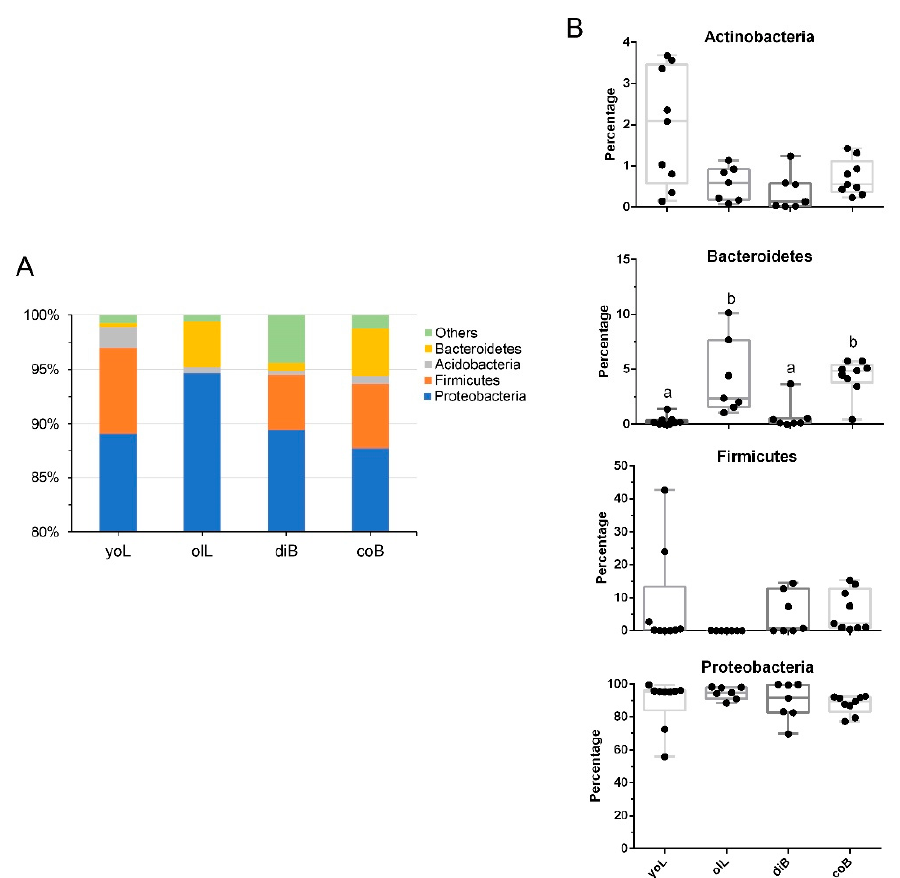
Figure 2. Phylum level composition. ( A ) Color-coded bar plot showing the average bacterial phylum distribution of the different groups sampled from gut communities of D. valens at different life stages (yoL, young larvae; olL, old larvae; diB, dispersal adults; coB, colonized adults). ( B ) The box shows the interquartile range of the relative abundance of the four main bacterial phyla from four groups: Proteobacteria, Firmicutes, Bacteroidetes, and Actinobacteria. Boxes represent the 25th and 75th percentiles. The solid line inside the box represents the median. Boxes with a different letter above are significantly different at p < 0.05.